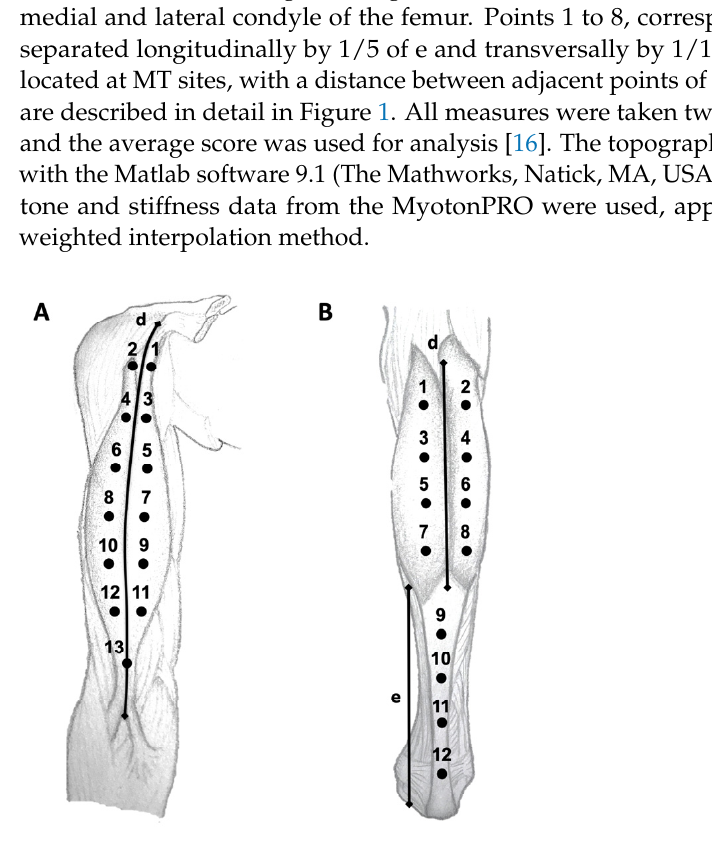
Figure 1. Measurement sites for the biceps brachii ( A ) and gastrocnemius ( B ) muscles. Resting measures of muscle thickness were obtained bilaterally at points 7 and 8 for the biceps brachii and at points 5 and 6 for the gastrocnemius muscle. We used B-mode ultrasound imaging (4.2 to 13 MHz) coupled with a multifrequency linear array transducer, model 12L-RS (GE Logiq V2, GE Health Care, Chicago, IL, USA). The average of two consecutive measures was taken for analysis. The muscle thickness was measured as the vertical distance between the superficial and deep aponeurosis for the gastrocnemius and between the adipose tissue–muscle interface and the muscle–bone interface for the biceps brachii [21].